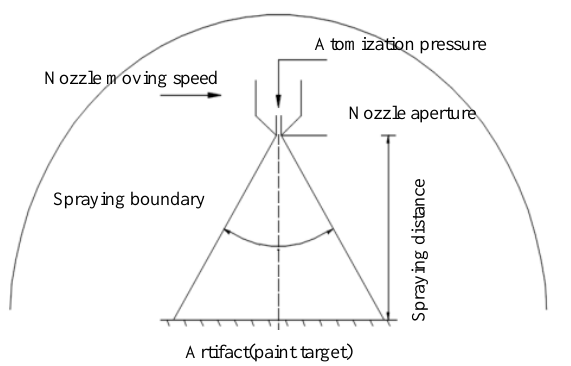
Figure 6. Spherical recovery cover.